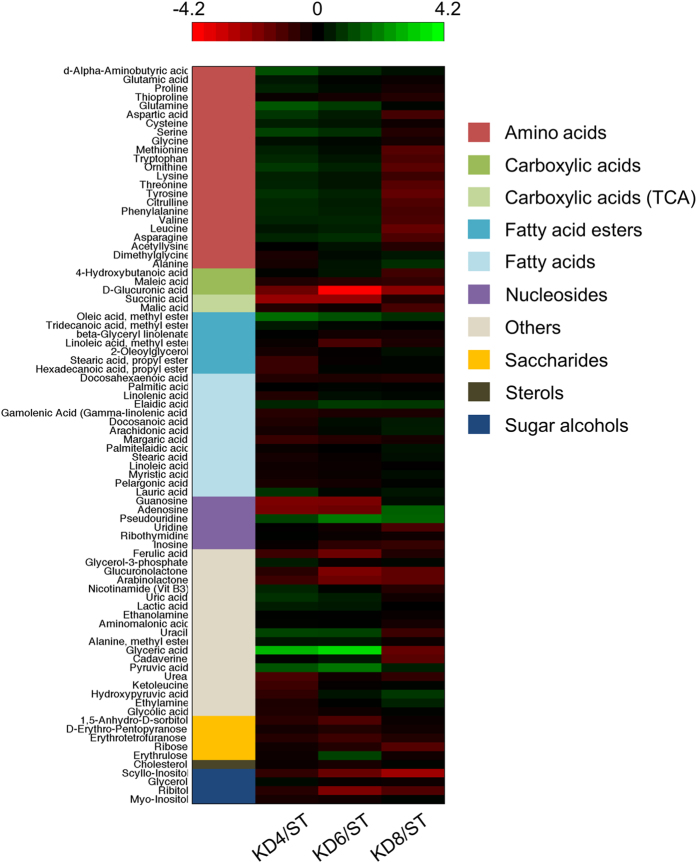
A heatmap visualisation of the changes in metabolite levels between the treatment groups KD4 (N = 4), KD6 (N = 6), KD8 (N = 5) and the control ST (N = 6).Each of the three heatmap columns represents one of the diet groups' (KD4, KD6 and KD8 respectively) log2 fold change in comparison to the control, with metabolite levels averaged across all of the specimens within each group. The compound group that each metabolite belongs to is colour-coded in the first column of the heatmap, with the mapping provided in the legend. Black indicates a log2 fold change of zero, representing a lack of change between the treatment group and the control. Increasing brightness of green indicates a higher level of the metabolite in the treatment group in comparison to the control (log2 fold change >0). Increasing brightness of red indicates a lower level of the metabolite in the treatment group in comparison to the control (log2 fold change <0). The log2 fold change corresponding to a given colour on the heatmap can be elucidated from the colour bar.